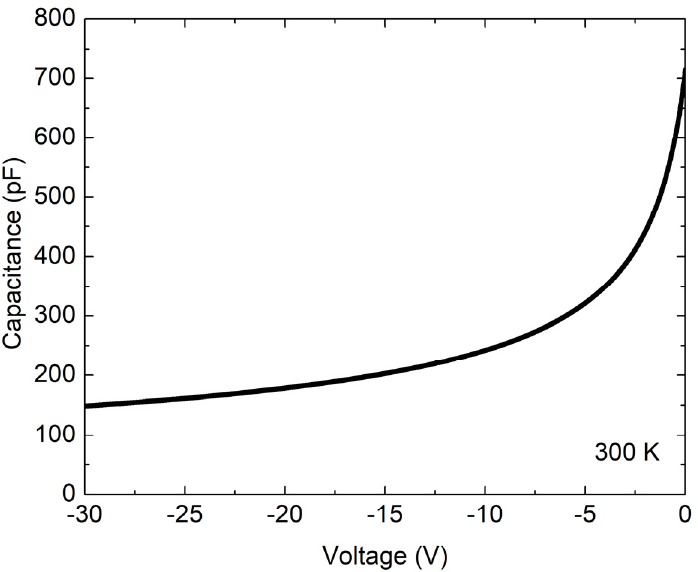
Figure 4. Capacitance current voltage (I-V) measurement of 4H-SiC detector with active surface area of 5 mm × 5 mm. Measurements were performed in a vacuum at 300 K.